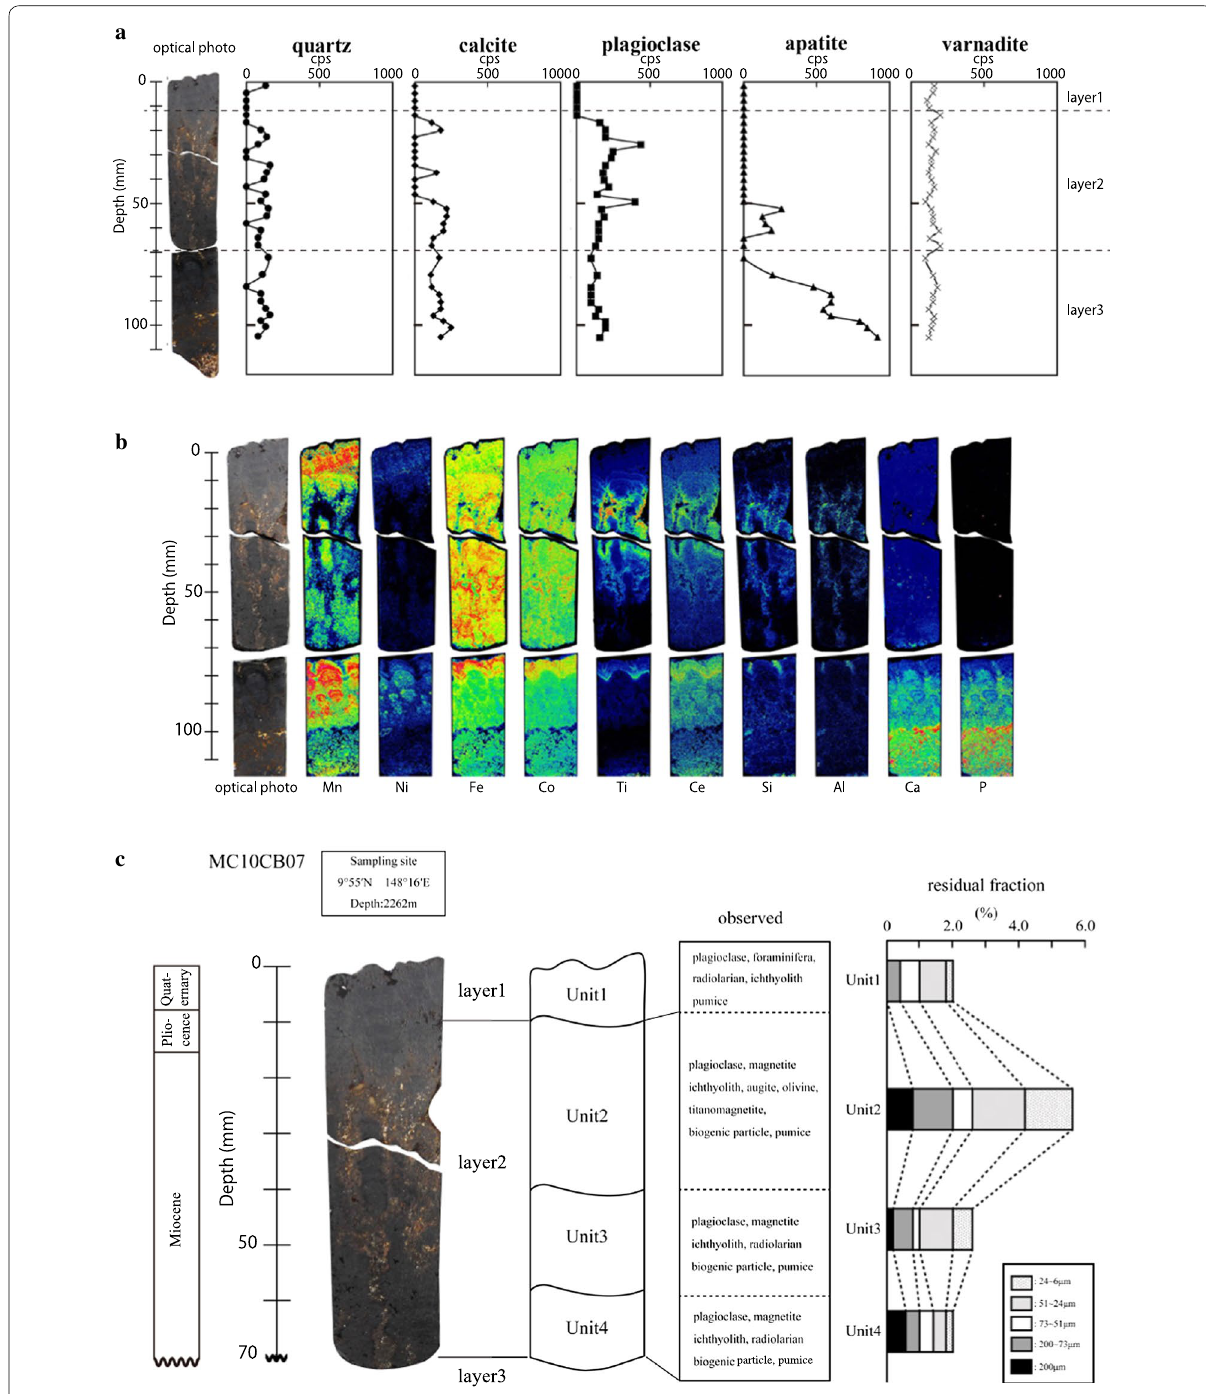
Fig. 2 a Results of XRD analyses measured on ~ 3 mm chip taken from polished section shown as photographic images on the left. Horizontal scale for each mineral show count per second (cps) value for a characteristic peak of each mineral. b Distribution of Mn, Ni, and Fe (from left to right) based on XRF analysis on another polished section shown as photographic images on the left. c Diagrams summarizing chemical leaching experiments. From left to right, age model based on 10 Be chronology, photograph of a polished section, units classified based on visual observations, optical microscopy and XRD analysis, observed materials within the residue, and fractions of each size within the residues. Observations for Fig. 3c were conducted using the material on 6-µm mesh sieve. ‘Biogenic particles’ in the observed materials column represents unidentified partially dissolved apatite particles considered to be originated from fossils. Residual fraction shows weight percentage of each size fraction obtained after chemical leaching of starting material (0.5